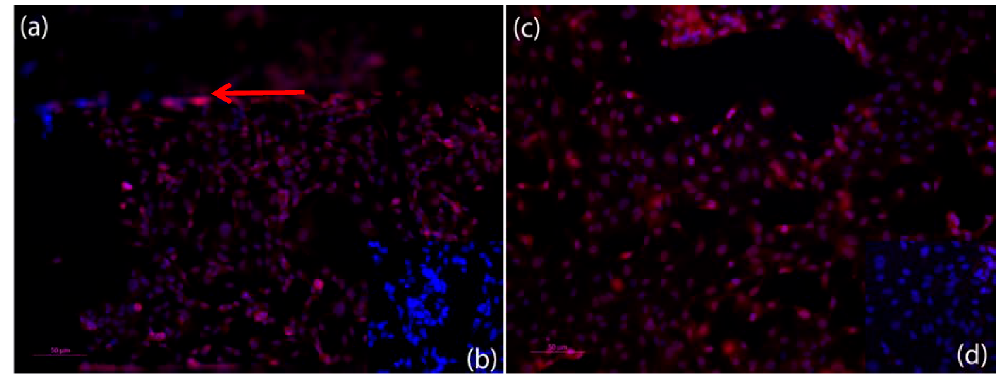
Figure 5. Fluorescent microscopic photos of anti-VE-Cadherin, Cy3 (red) immunofluorescence staining of HPAEC endothelial cells in the microfluidic device after finishing an experiment (nuclei stained with Hoechst) (blue). ( a ) Anti-VE-Cadherin Staining of the HPAEC endothelial cells within the microfluidic channel after an experiment. Red arrow shows edge of channel. VE-Cadherin can be detected on the surface of all endothelial cells and shows adherence junction expression; ( c ) Anti-VE-Cadherin staining of the HPAEC endothelial cells on top of the porous membrane of the microfluidic device after an experiment. VE-Cadherin can be detected on the surface of all of the endothelial cells and shows adherence junction expression. ( b , d ) Negative control for ( a , c ) show that method was conducted appropriately. Dilution of antibodies: 1st antibody anti VE-Cadherin 1:200, and 2nd antibody Cy3 anti rabbit 1:500). Scale bar: 50 µm.